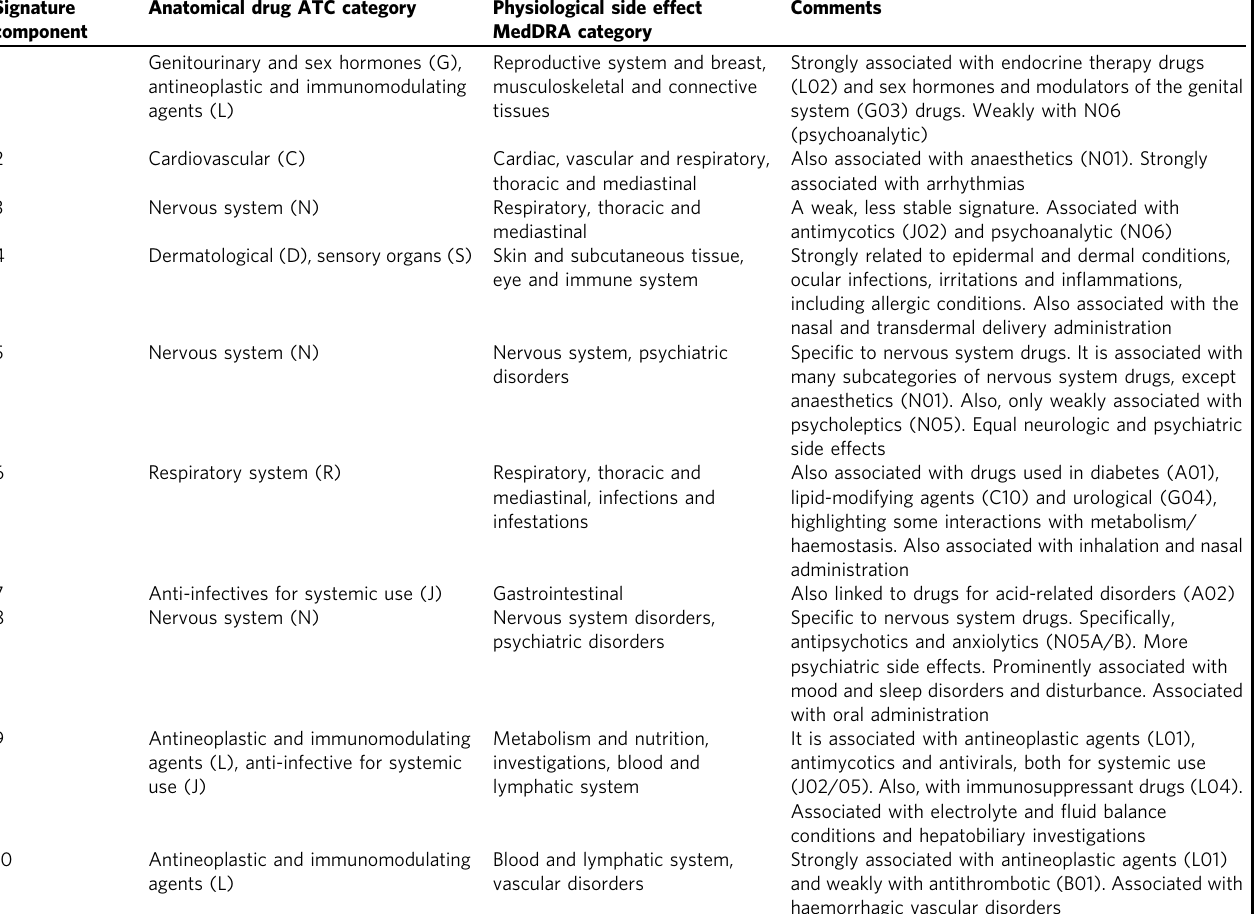
Table 1 Statistically signi fi cant associations with each signature